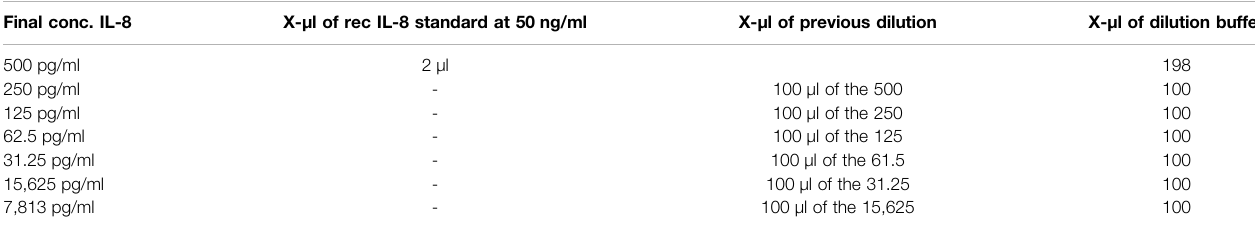
TABLE 9 | Dilution of the recombinant human IL-8 antibody required for a standard curve. Final conc.